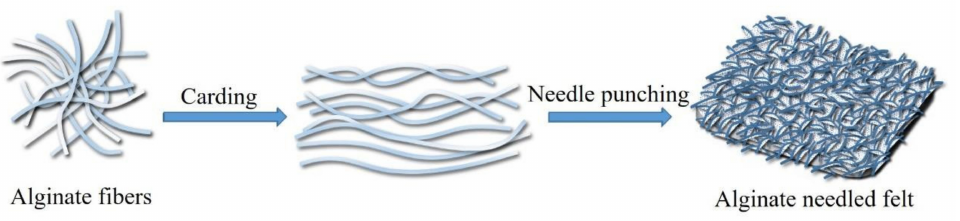
Figure 4. Preparation of the alginate nonwoven fabric by the acupuncture